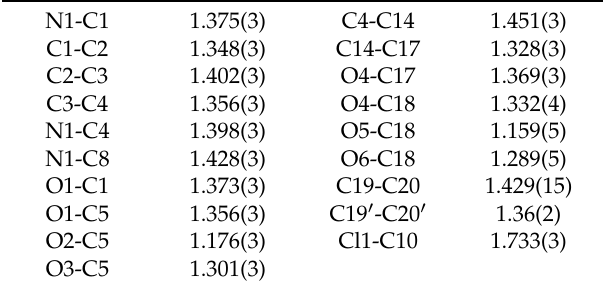
Table 2. Selected geometric parameters of compound 6b (Å).